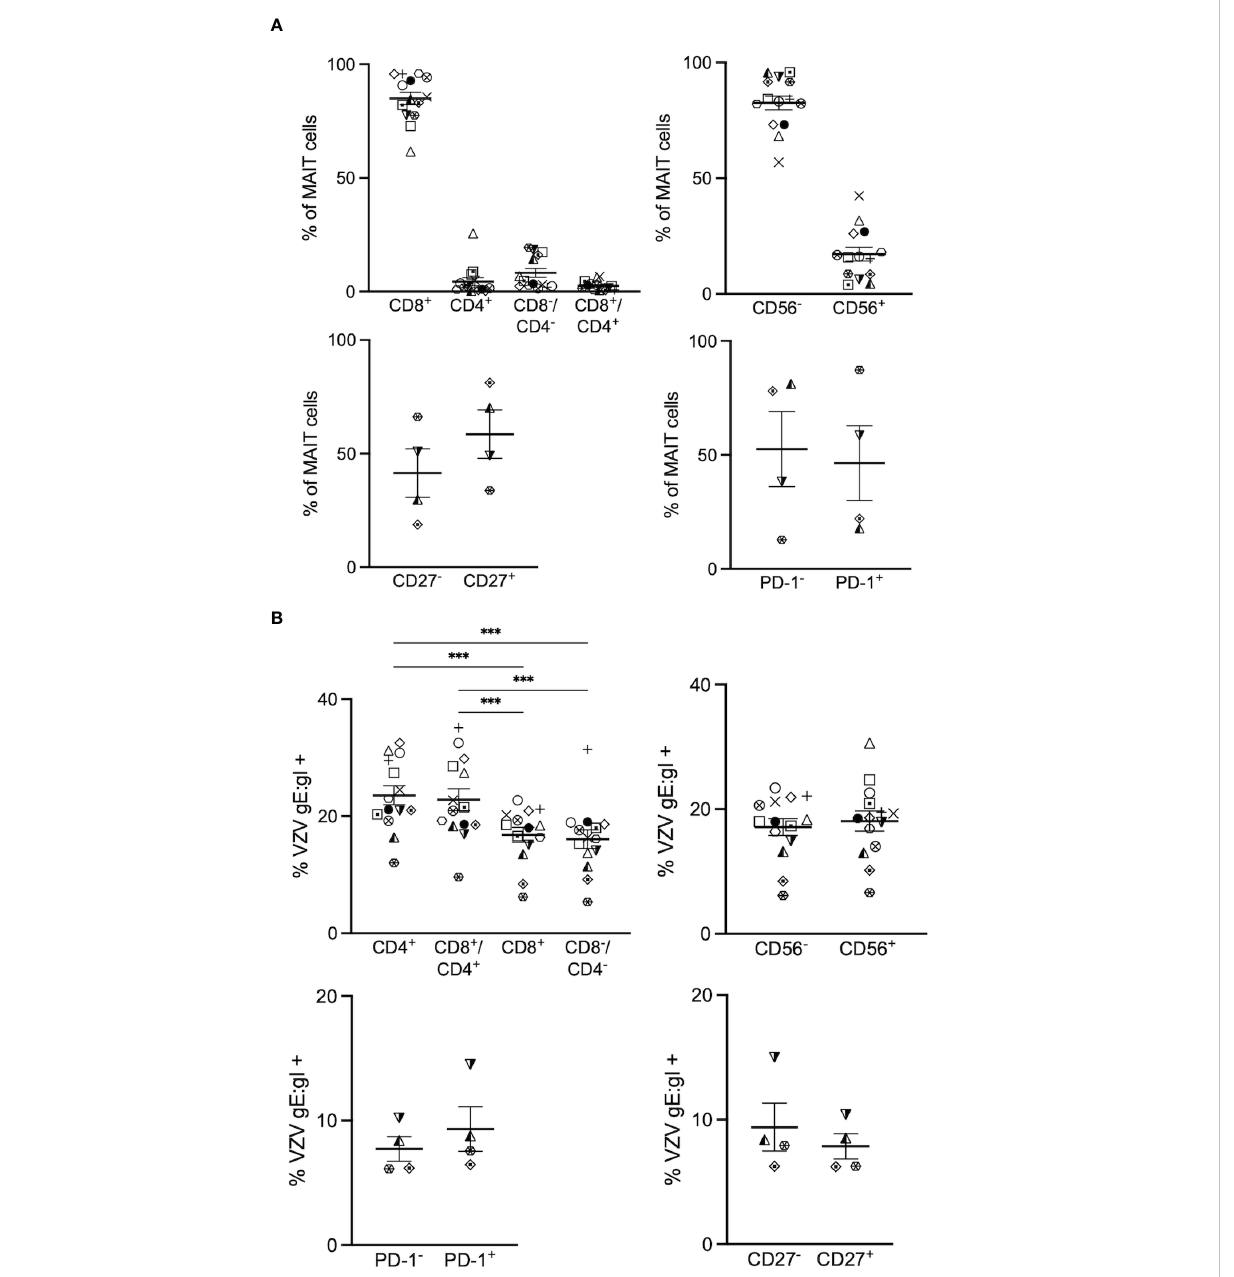
FIGURE 2 VZV infects diverse MAIT cell subsets. Human PBMCs were inoculated with mock or VZV-S infected ARPE-19 epithelial cells for 2 days and then analyzed for infection by fl ow cytometry as per surface VZV-gE:gI expression (A) Graphs showing frequencies of various MAIT cell subpopulations (n=4-14). (B) Frequencies of gE:gI + lymphocytes within each subpopulation depicted, with symbols representing individual donors across the MAIT subpopulations, with mean and SEM indicated by the bars. Statistical analysis of VZV gE:gI expression, comparing CD4 + cells with CD8 + cells, and CD4 + /CD8 + cells compared to CD4 - /CD8 - cells was performed via RM one-way ANOVA with the Greenhouse-Geisser correction and Tukey ’ s multiple comparisons test (n=14).***p<0.001. Statistical analysis of gE:gI expression on MAIT cells expressing CD56 - was compared to those expressing CD56 + (n=14), CD27 - compared to CD27 + (n=4) and PD-1 - compared to PD-1 + (n=4) was performed via two tailed paired t